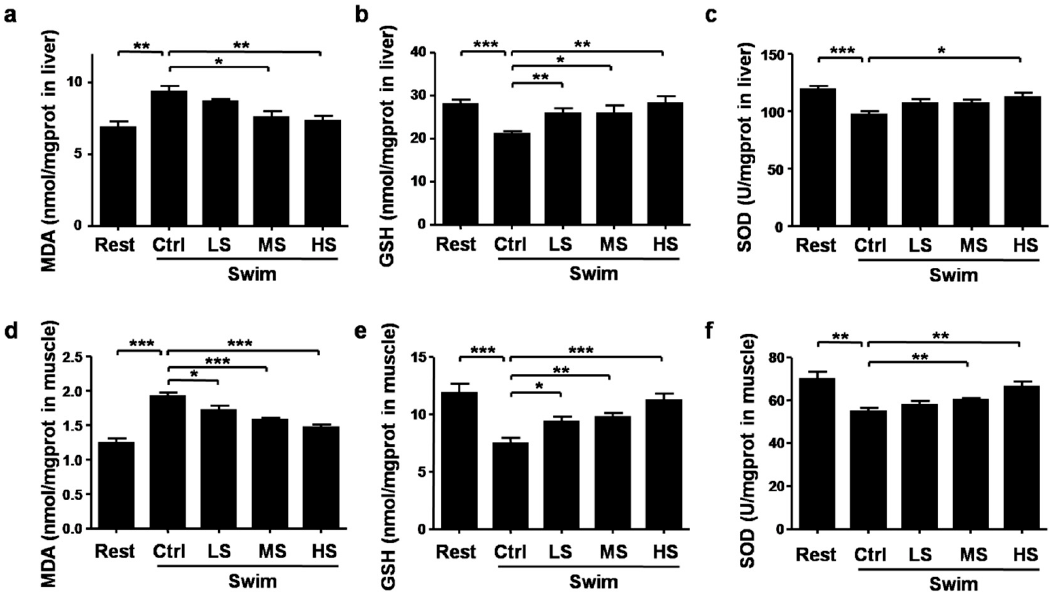
Figure 6. The effects of Salecan on oxidative stress-related parameters in the liver and muscle of mice from different groups. ( a ) Liver MDA; ( b ) liver GSH; ( c ) liver SOD; ( d ) muscle MDA; ( e ) muscle GSH; and ( f ) muscle SOD. Data are expressed as mean ± SD, N = 6, * p < 0.05, ** p < 0.01, *** p < 0.001. Rest, the control group without swimming; Swim-Ctrl, the control group that swim for 15 min before sample collection; Swim-LS, the low-dose of Salecan-treated group that swim for 15 min before sample collection; Swim-MS, the medium-dose of Salecan-treated group that swim for 15 min before sample collection; Swim-HS, the high-dose of Salecan-treated group that swim for 15 min before sample